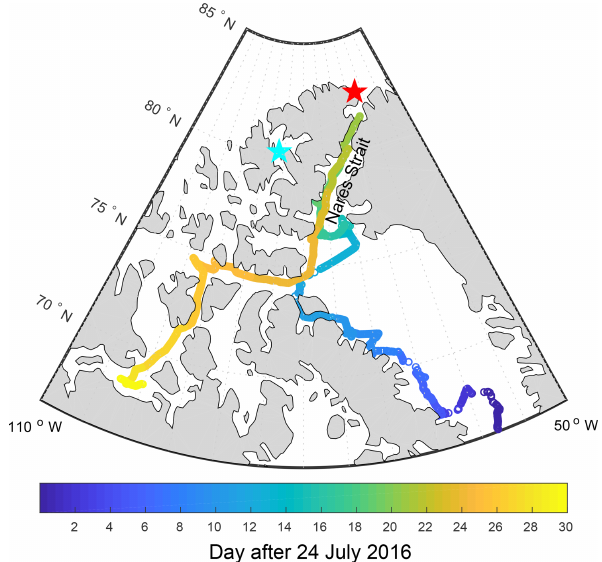
Figure 1. CCGS Amundsen 2016 cruise track through Canadian Arctic Archipelago color coded by the number of days after 24 July 2016. Land is shaded in grey. The locations of Alert and Eureka are shown using red and cyan stars,